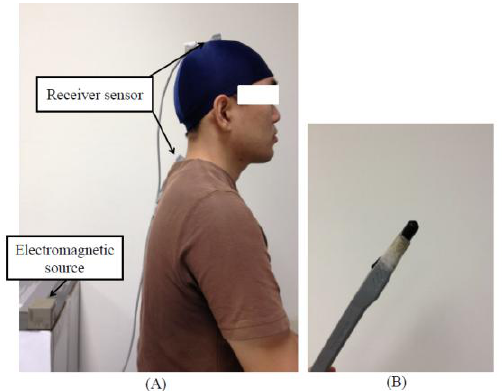
Figure 1. Experimental set-up to collect the movement trajectories of the motion of cervical circumduction: ( A ) Placement of applied electromagnetic source and receiver sensors; ( B ) Another receiver sensor was mounted on a palpation